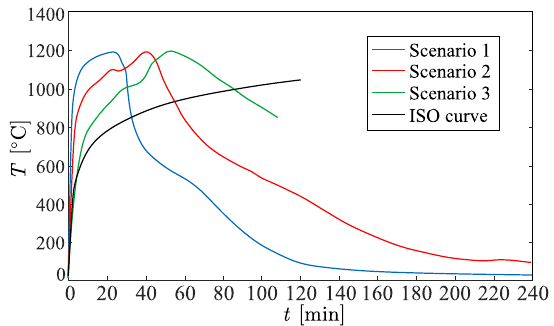
Fig. 2 a The development of charring depth for varied parameter E 1, (cid:31) . b Sensitivity index S char, E charring